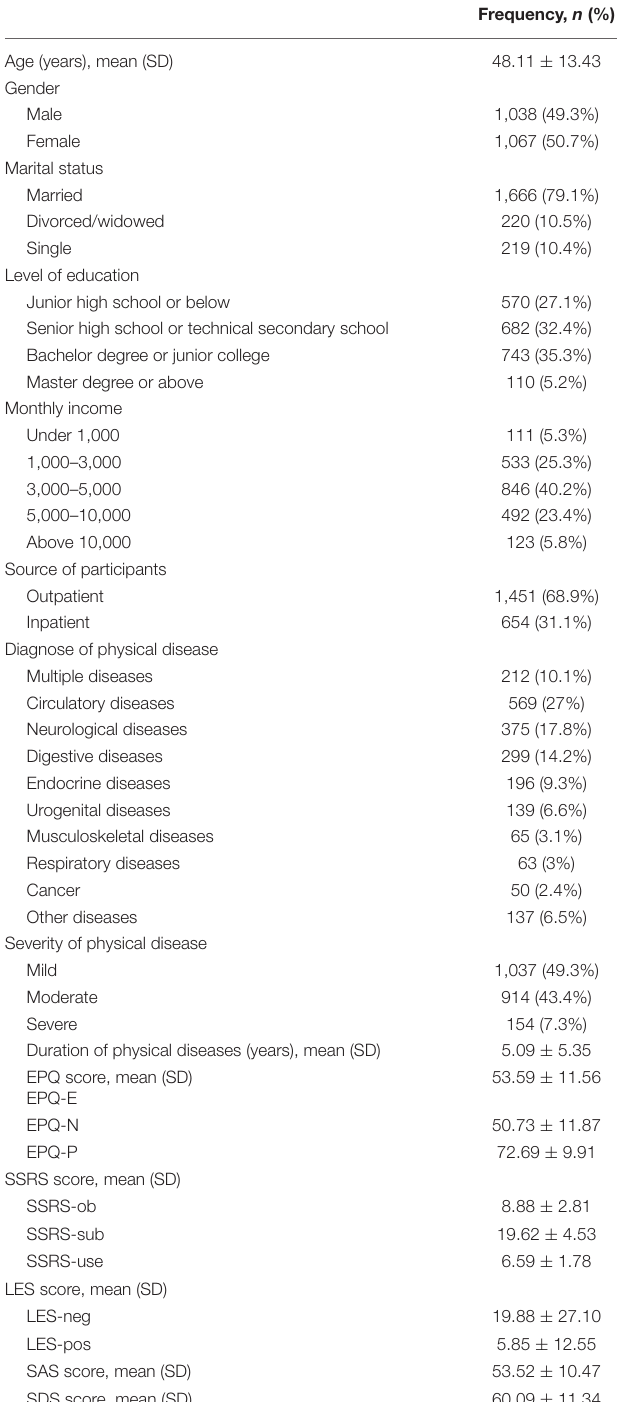
TABLE 1 | Demographic and clinical characteristic of all patients ( n =